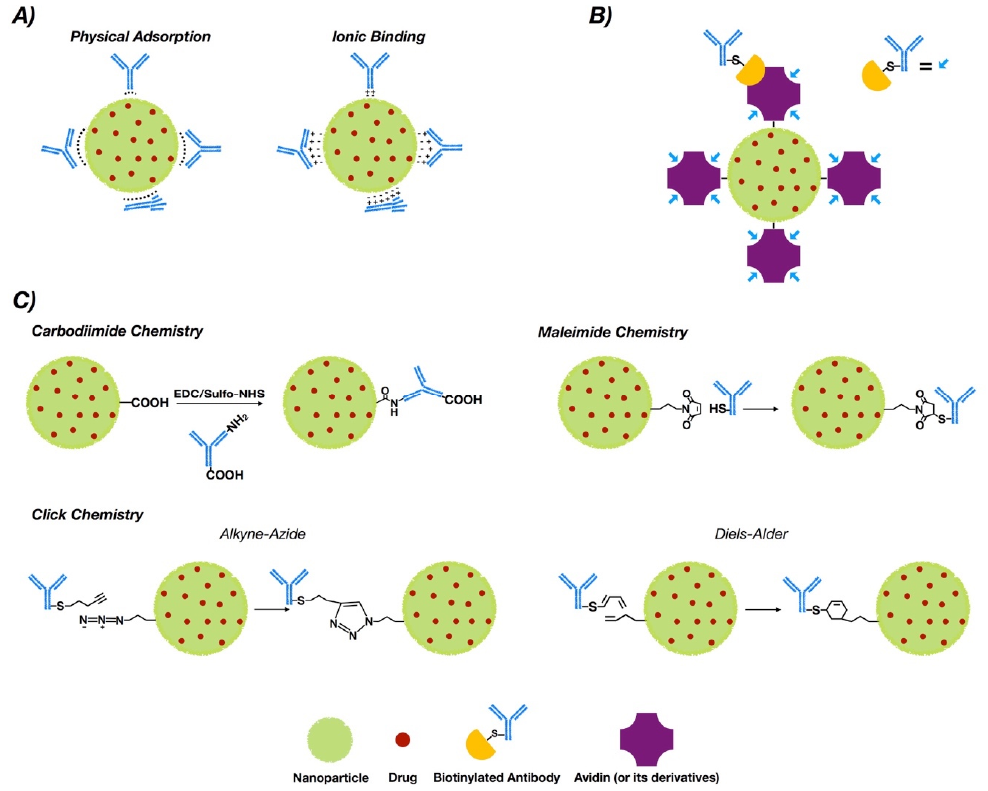
Figure 1. Conjugation strategies for antibody conjugated nanoparticle (ACNP) generation: ( A ) adsorption; ( B ) use of adapters; and ( C ) covalent binding.